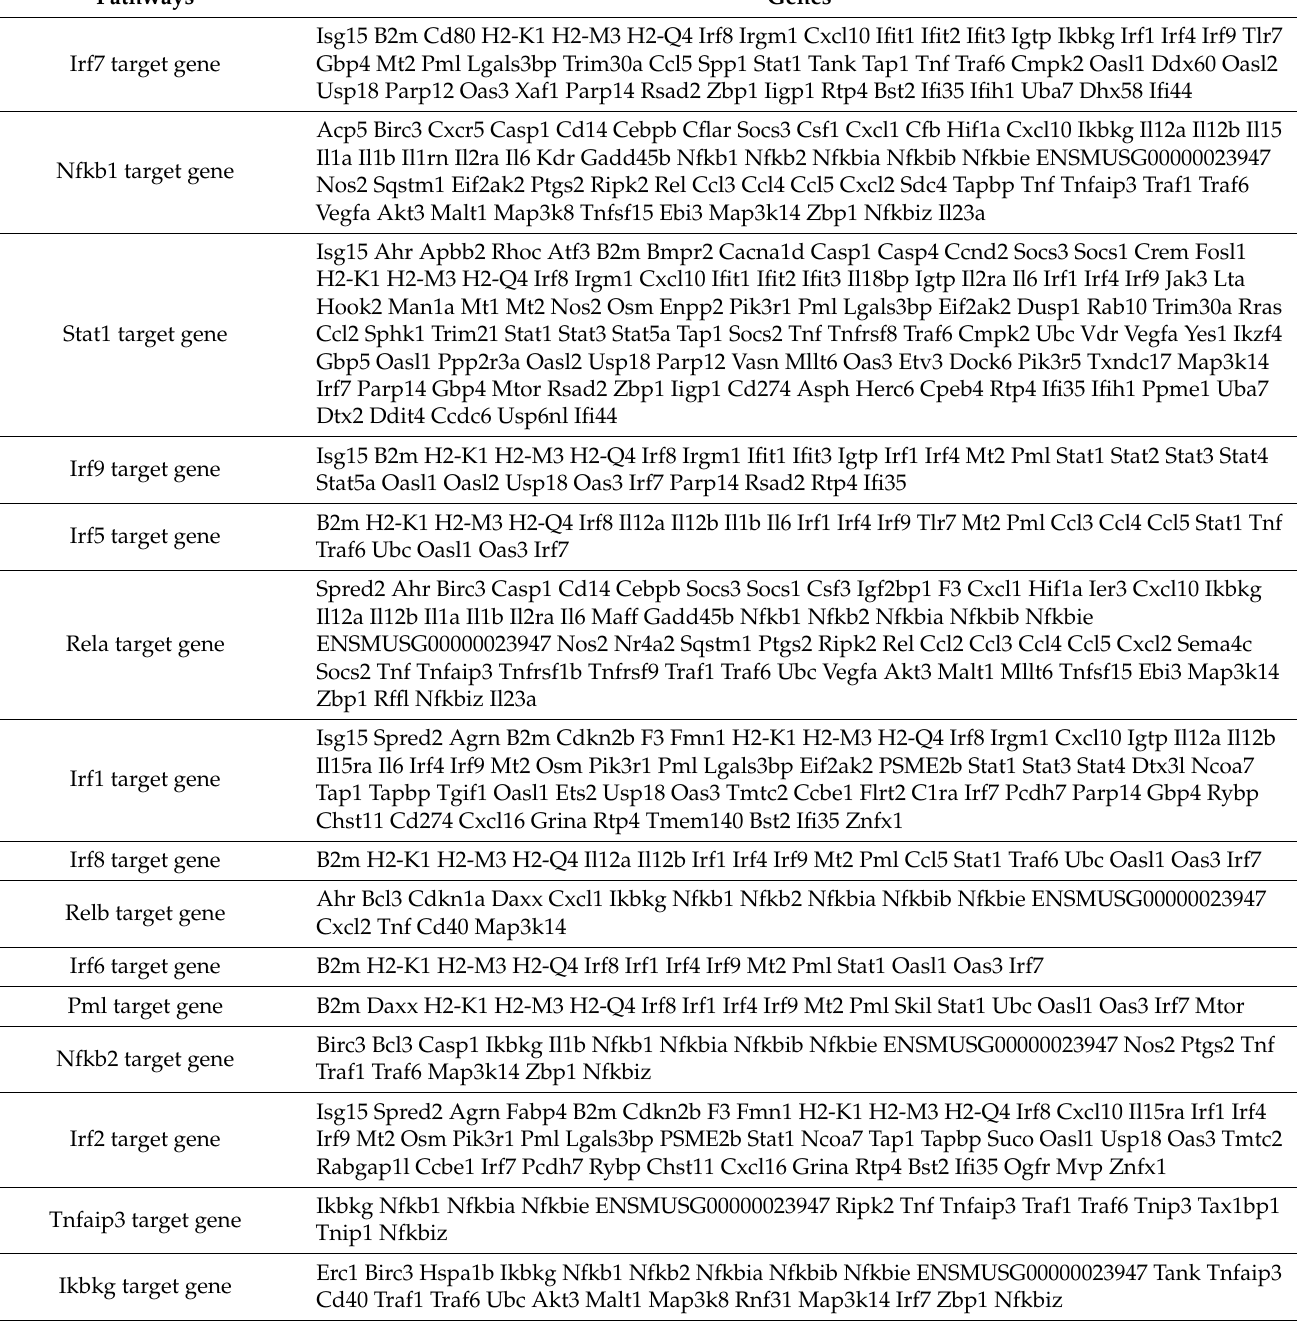
Table 2. Transcription factor pathways with target genes upregulated by fucoidan treatment. Pathways